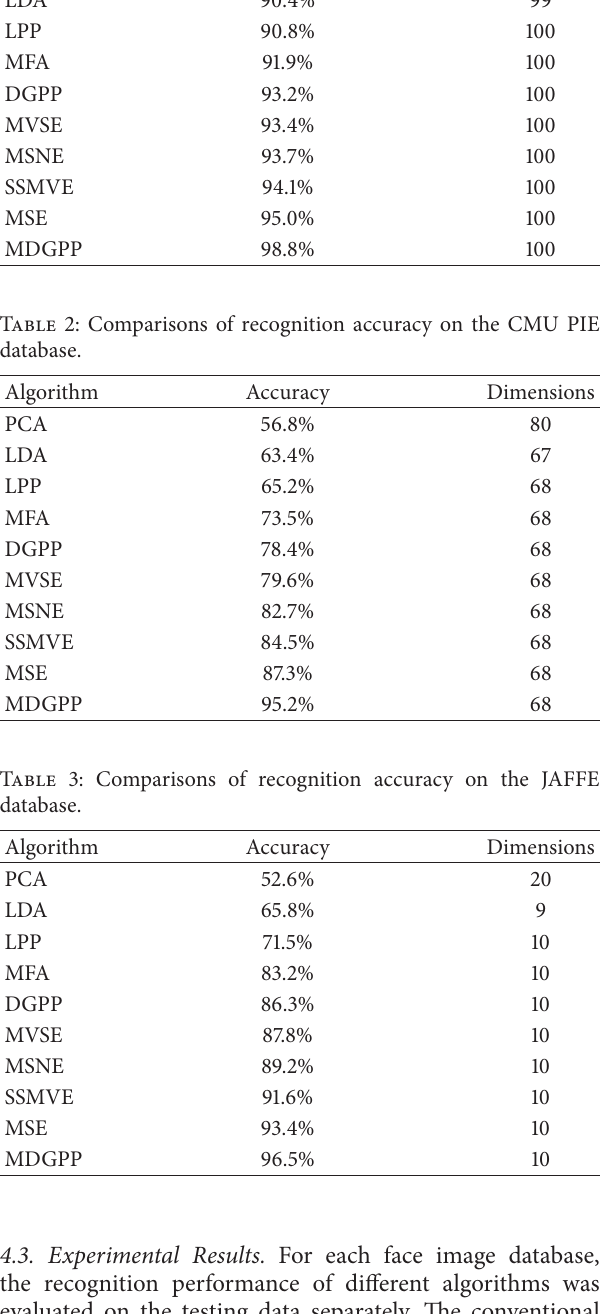
Figure 3: Sample facial images from the JAFFE database.